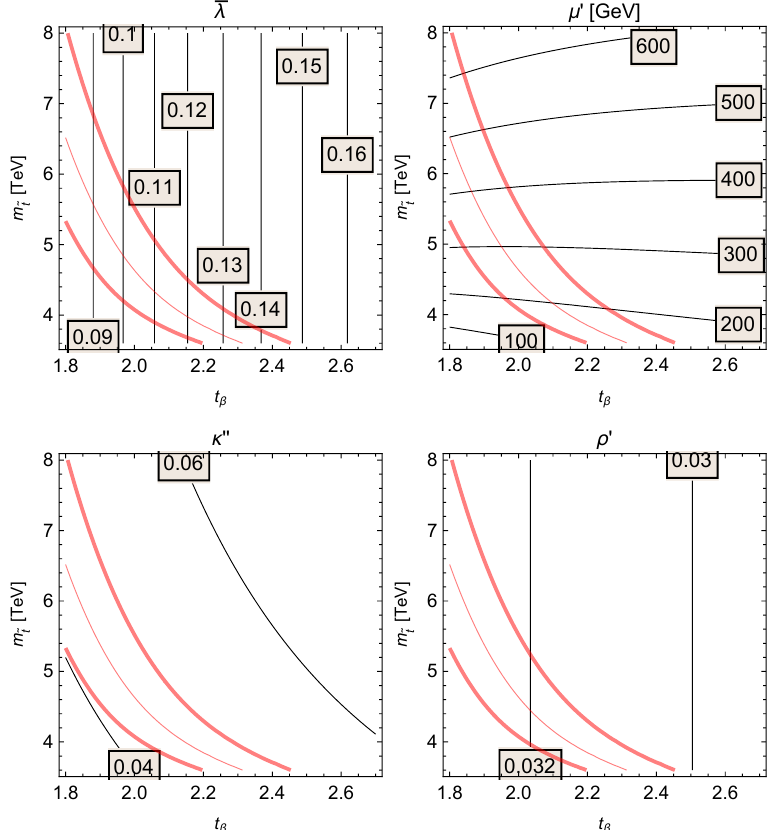
Figure 11 . The e(cid:11)ective quartics and soft Z 2 breaking term in the low-energy TMNT potential arising from a D -term supersymmetric UV completion with the speci(cid:12)c values of input parameters listed in table 3. The red lines in this (cid:12)gure indicate the range of parameters that generates a higgs mass between (122 ;